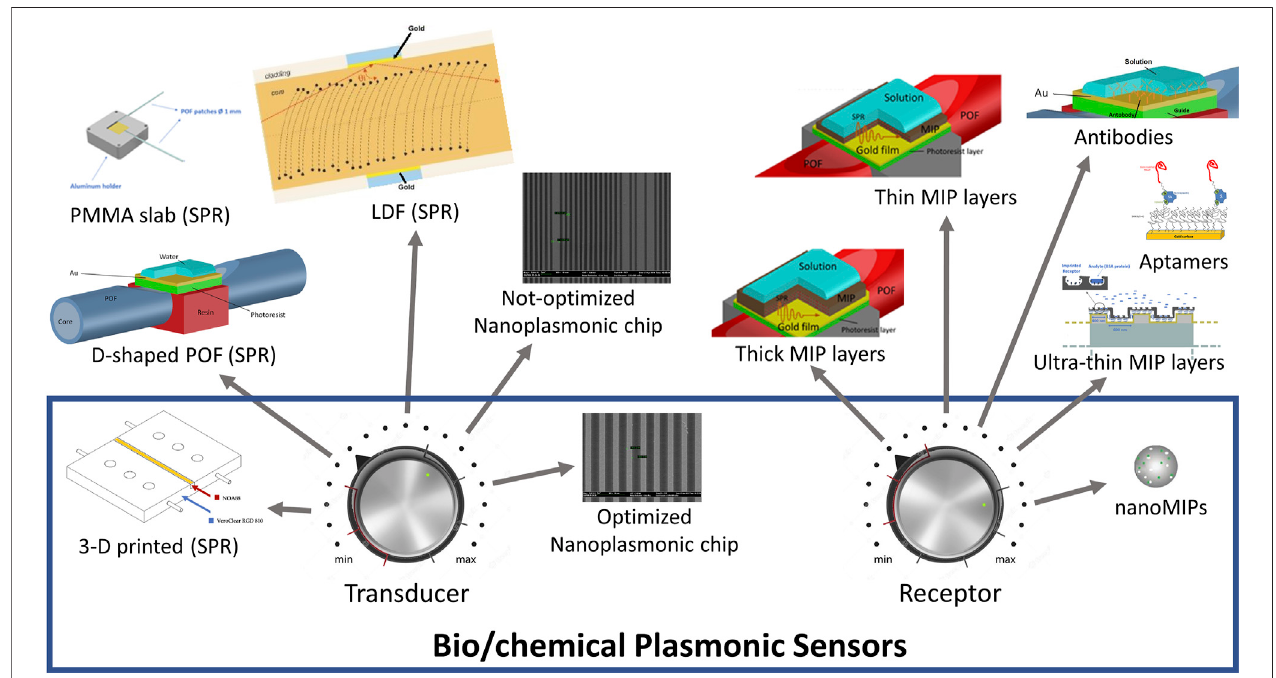
FIGURE 10 | An example of a summary on the designer ’ s choices of transducers and receptors combinations so to realize custom bio/chemical sensor devices.